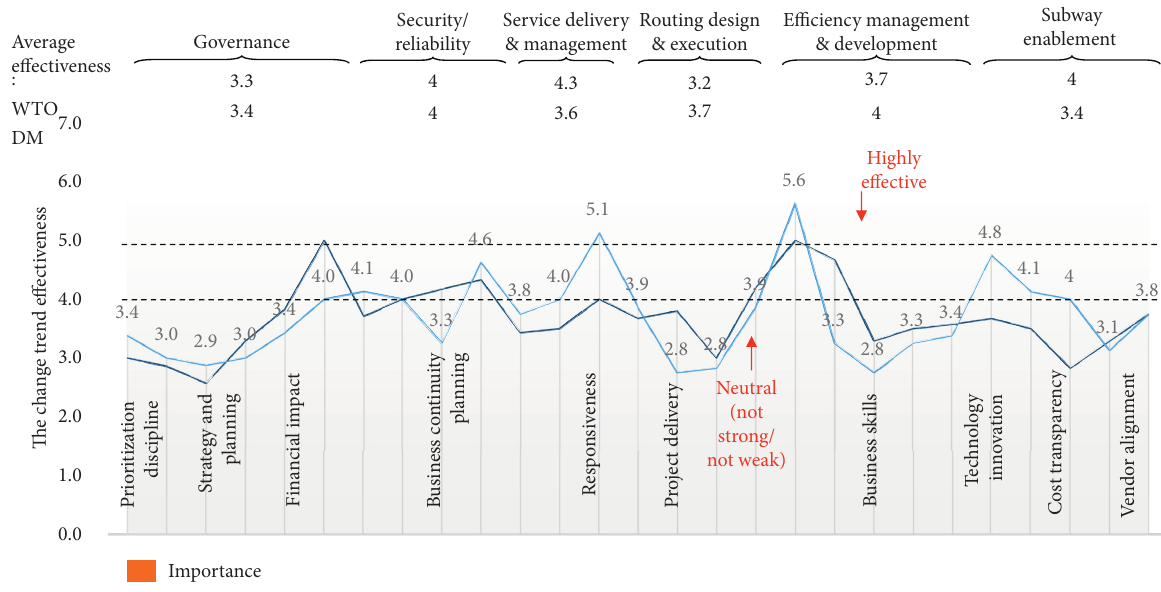
Figure 10: The change trend of the subway health assessment value with the health status. Highly effective and neutral are shown by the red